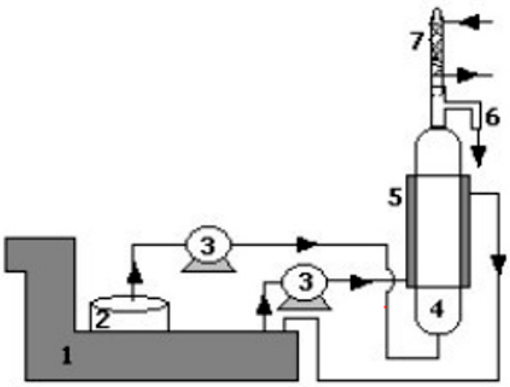
Figure 6. Schematic laboratory apparatus for continuous extraction: (1) water bath, (2) fresh solvent vessel, (3) peristaltic pumps, (4) extraction column, (5) column jacket, (6) extraction outlet, (7) condenser.